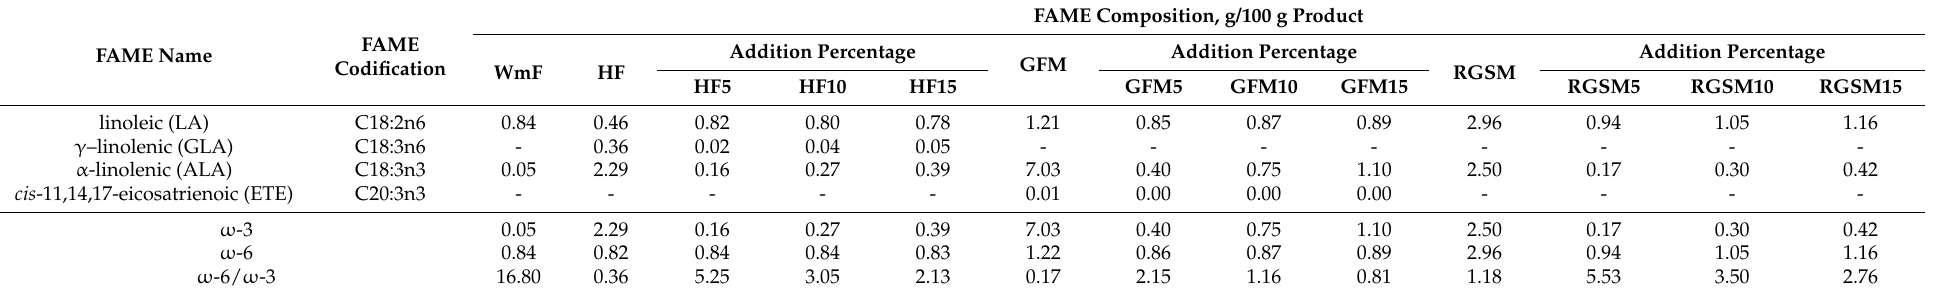
Table 7. Influence of different percentages of hemp flour, golden flax meals, and red grape seeds meals addition on the ω -3 and ω -6 fatty acids of wholemeal